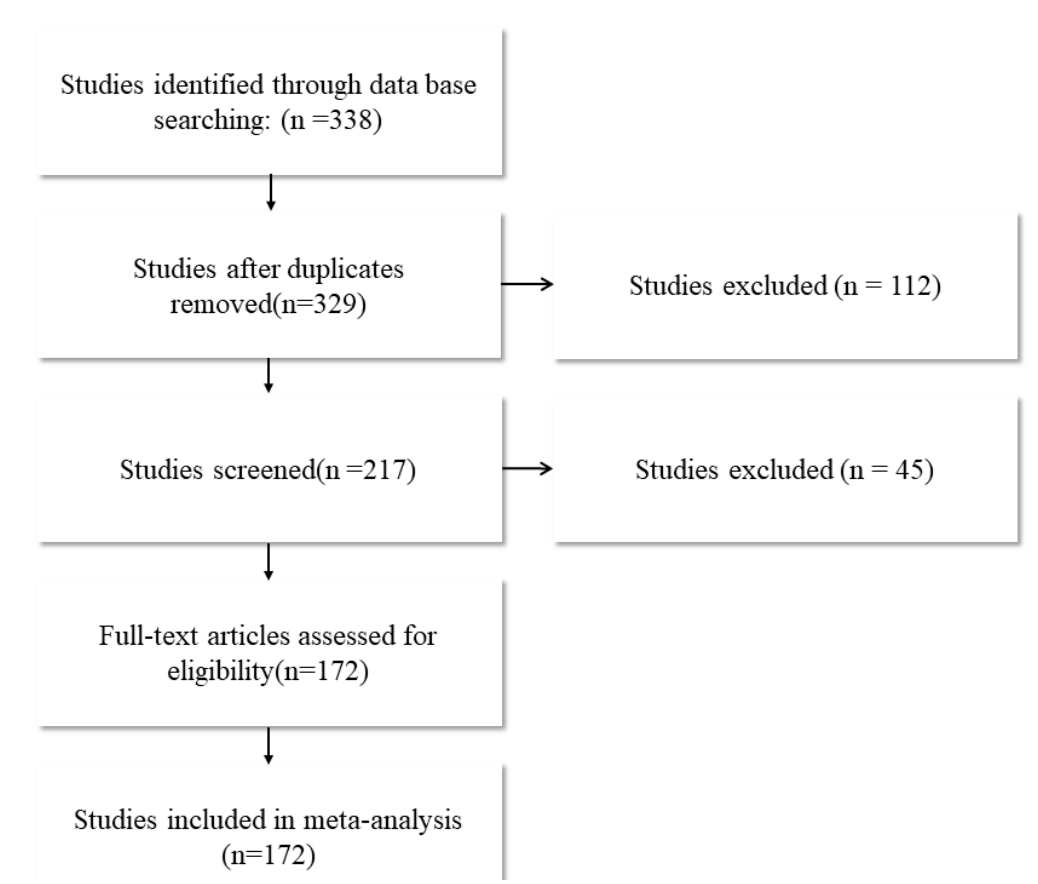
Figure 3. PRISMA flow diagram for selecting relevant articles. Initially 338 articles were found through the designed search criteria, with nine duplicates removed. We removed articles that integrated SAR and optical data, leaving 217 studies. After screening the 217 articles, 172 of them were chosen for analysis.